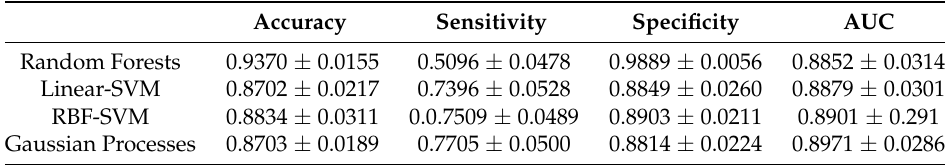
Table 5. AUC, accuracy, sensitivity and specificity related to the bright-lesion detection on DIARETDB1 database for each classification method using a decision threshold δ = 0.5.